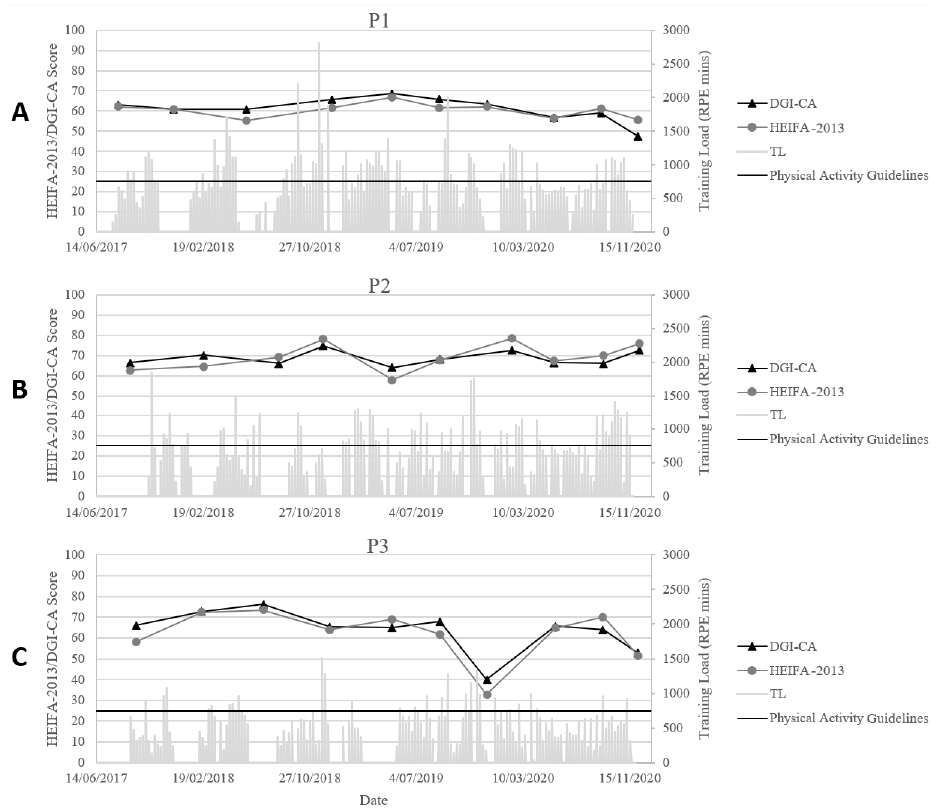
Figure 3. Training load (TL) data (bar graph) and the associated physical activity recommendation for the general population (red line) overlayed with the dietary index scores (line charts)—Dietary Guideline Index for Children and Adolescents (DGI-CA), and the Healthy Eating Index for Adults (HEIFA-2013) for participant 1 (P1) ( A ), participant 2 (P2) ( B ), and participant 3 (P3) ( C ).